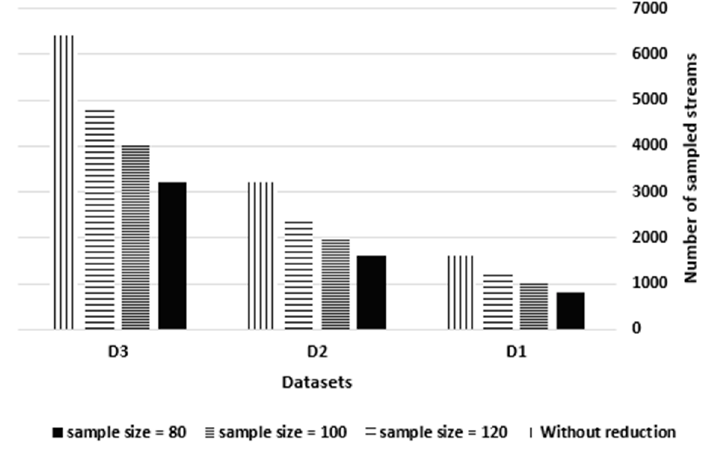
Figure 8. The number of sampled streams vs. the sample size.